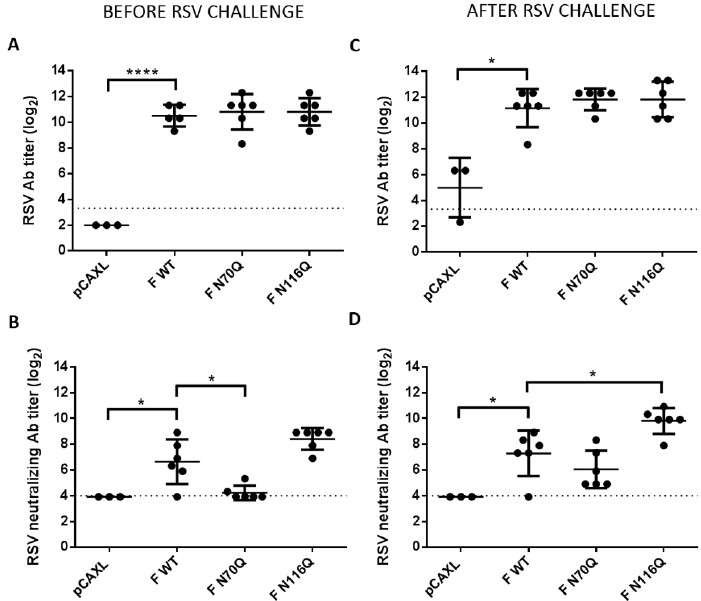
Figure 7. Antibody responses before and after challenge of immunized mice. Antibody ( A ) and neutralizing antibody responses ( B ) after immunization and before infection. Antibody ( C ) and neutralizing antibody responses ( D ) after immunization and after infection. To determine serum antibody titres RSV A2-K-line19F infected HEp-2 monolayers were titrated with 2-fold serial dilutions of heat-inactivated serum after methanol fixation. Binding of the antibodies was detected by HRP-conjugated goat anti-mouse IgG and DAB. Endpoint titres were determined by light microscopic analysis. ( B ) Plaque reduction neutralization test (PRNT) was performed by incubation of serial two-fold dilutions of heat-inactivated serum with RSV A2-K-line19F for 1 h at 37 °C prior to inoculation of HEp-2 monolayers. Plaques were visualized by immunostaining with palivizumab and HRP-conjugated secondary antibodies. The 50% endpoint titres were determined by manual plaque counting. * p < 0.05, **** p < 0.0001; n = 3–6 animals/group (Student’s unpaired two-tailed t test).